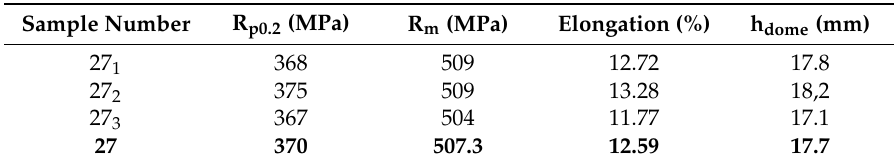
Table 4. Mechanical properties of tested steel sheet obtained by biaxial tensile test (test specimen No. 27): the bold represents average value.